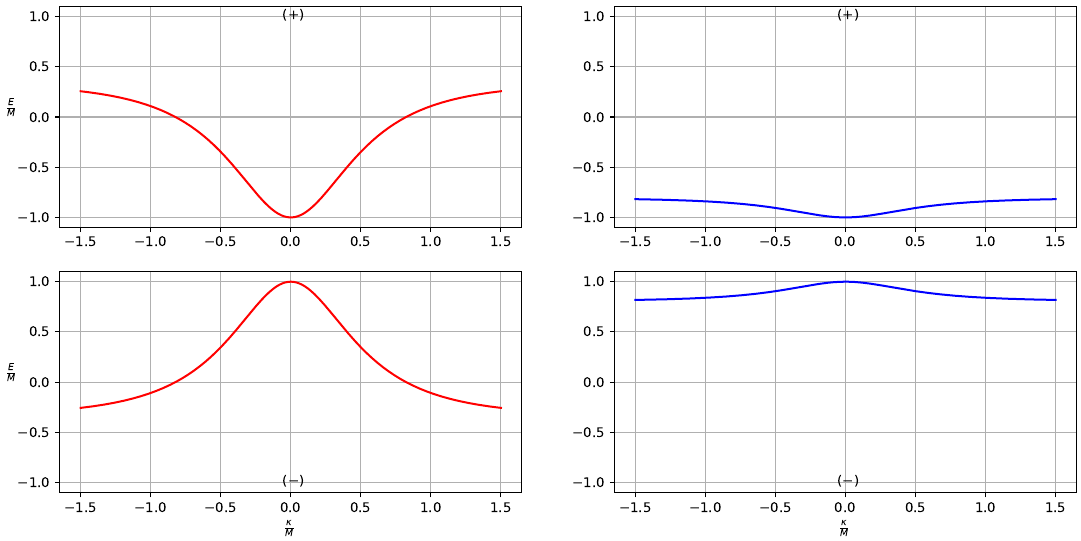
Figure 23 . E vs κ for θ 0 = π/ 3 . The parities of the bound states are indicated as ( ± ) . These M M plots show in-gap states ( | E | < 1 ). M